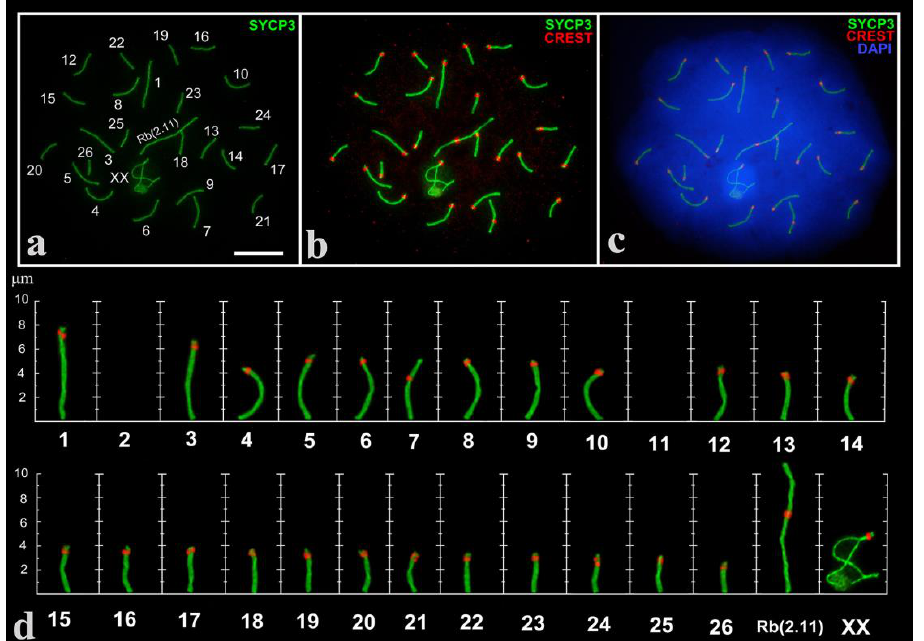
Figure 1. Pachytene spermatocyte ( a – c ) and synaptonemal complex (SC) karyotype ( d ) of the Alay mole vole, E. alaicus . SCs were immunostained with antibodies against synaptonemal complex protein 3 (SYCP3) (green) and centromeres—with antibodies to kinetochores (Calcinosis Raynaud’s phenomenon, Esophageal dysmotility, Sclerodactyly, and Telangiectasia (CREST), red). The 4′,6-diamidino-2-phenylindole (DAPI)-stained the chromatin (blue). SC numbers corresponded to the metaphase karyotype. Rb(2.11)—Robertsonian submetacentric. Chromosome №7